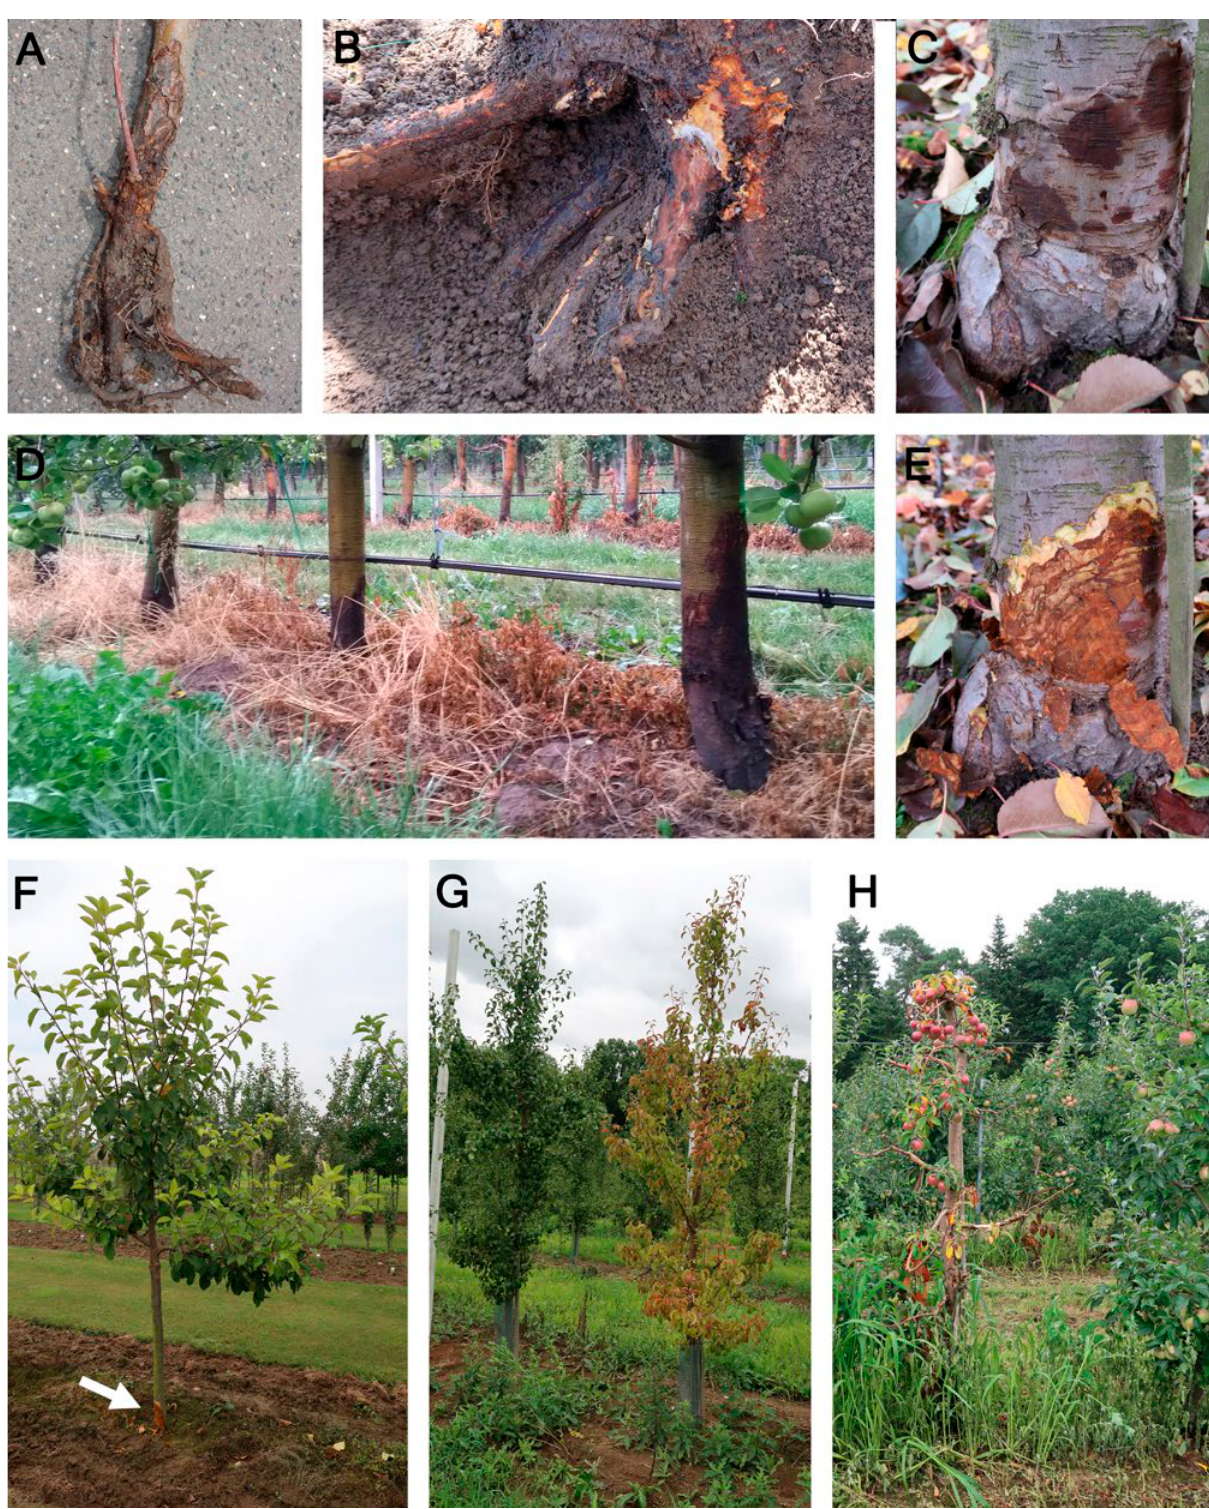
Figure 1. Characteristic symptoms of Phytophthora root and collar rot of Malus domestica (A–F, H) and Pyrus communis (G): A, root and collar rot of a young tree; B, root rot of a mature tree; C, characteristic tar spots on a tree collar; D, some apple orchards severely damaged by the disease; E, collar rot after the removal of bark (tree from Picture C); F, young tree with yellowed foliage resulting from collar rot (arrow); G, characteristic foliage yellowing of a pear tree; H, heavily diseased trees are characterised by production of small